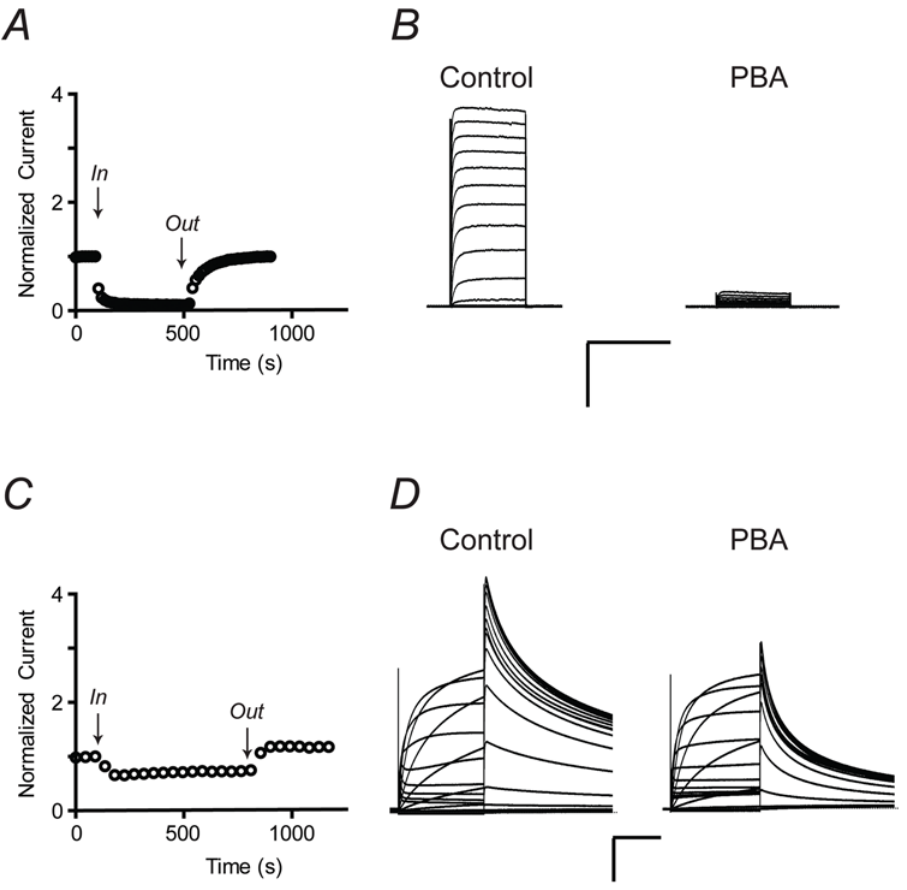
Figure 4. PBA inhibits other Kv channels. ( A ) Time course of Shaker (inactivation removed) current measured in ND96 at + 40 mV, 100 ms pulse when 10 mM PBA was applied through the bath solution. ( B ) Families of Shaker currents recorded before and during treatment with PBA. Currents were elicited by 100 ms step test potentials from 2 100 to + 60 mV in 10 mV increments from a holding potential of 2 80 mV. Dashed line indicates zero current. Scale bars represent 1 m A and 0.1 s. ( C ) Time course of hERG current measured in ND96 at 0 mV, 2 s pulse when 10 mM PBA was applied through the bath solution. ( D ) Families of hERG currents recorded before and during treatment with PBA. Currents were elicited by 2 s step test potentials from 2 100 to + 60 mV in 10 mV increments from a holding potential of 2 80 mV. Dashed line indicates zero current. Scale bars represent 1 m A and 0.5 s.